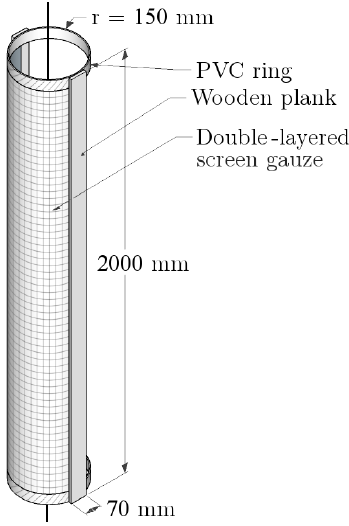
Figure 3. Schematic of one 2m segment of the solar screen con-